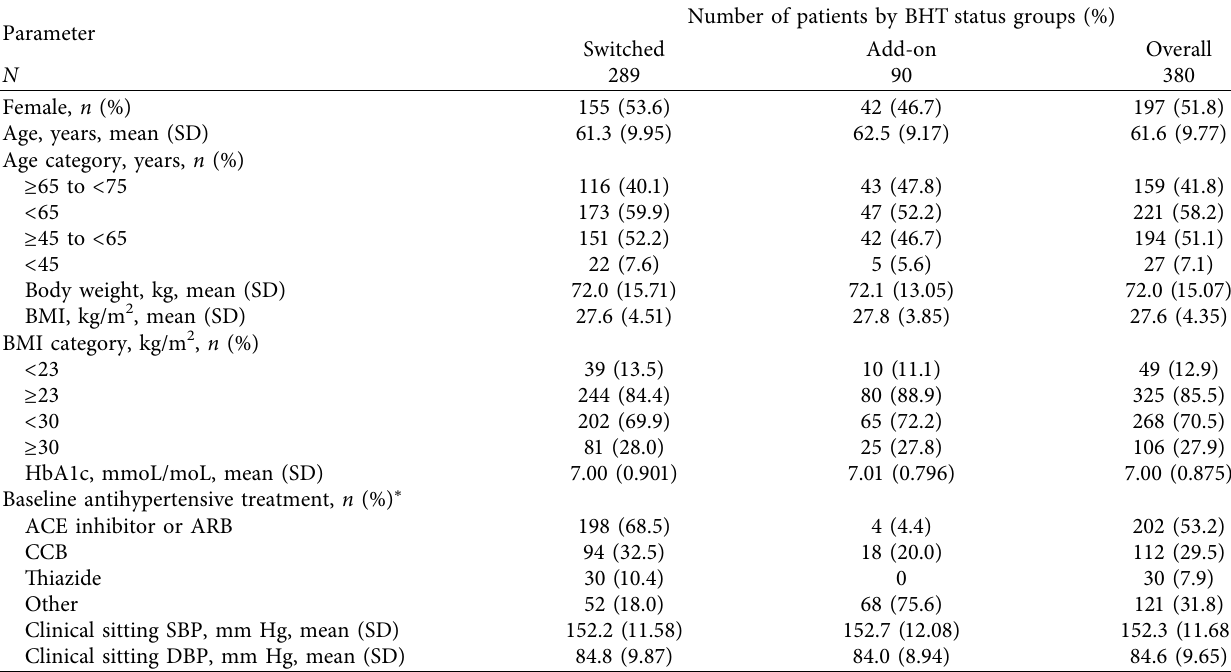
Table 1: Key demographic and baseline characteristics (safety analysis set).